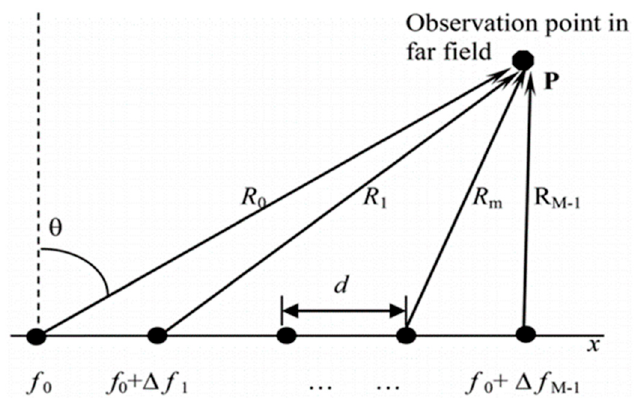
Figure 1. The schematic of frequency diversity array.